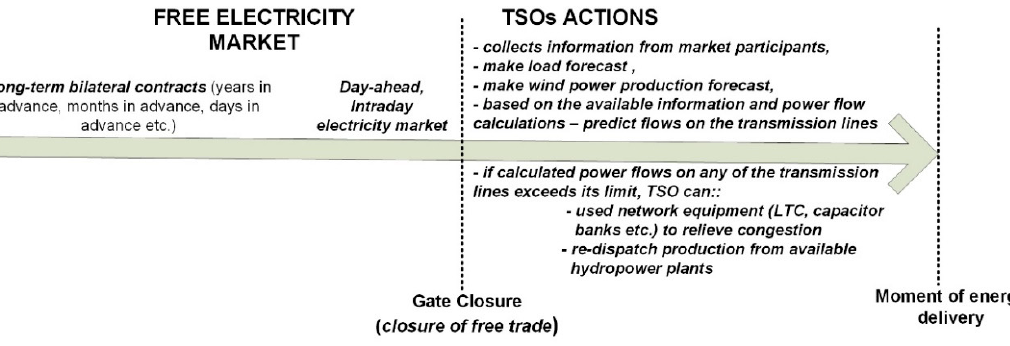
Figure 1. Relationships between the electricity market, transmission system operator (TSO) actions, and real-time delivery of electric energy.